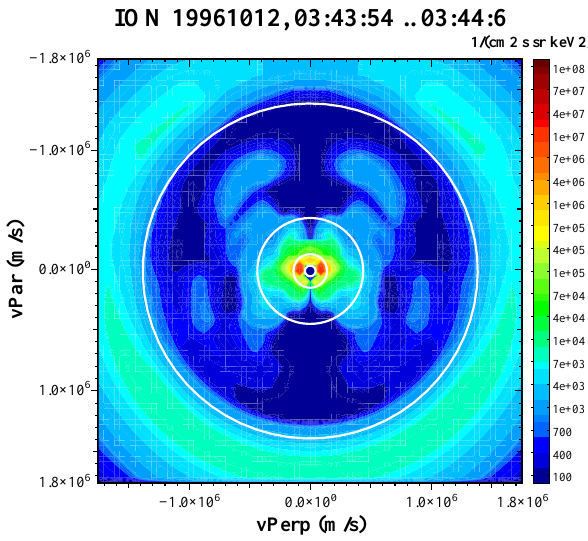
Fig. 3. Example of an event containing a full (i.e. up/down symmet- ric) ion shell distribution in the PSBL. Format is similar to Fig. 2. One-count level is 200 times smaller than the shell distribution level, MLT 0.9, ILAT 69.5, R = 4 . 3 R E , n = 0 . 26cm − 3 , T = 8 . 6keV, free energy density 0.64keVcm − 3 .